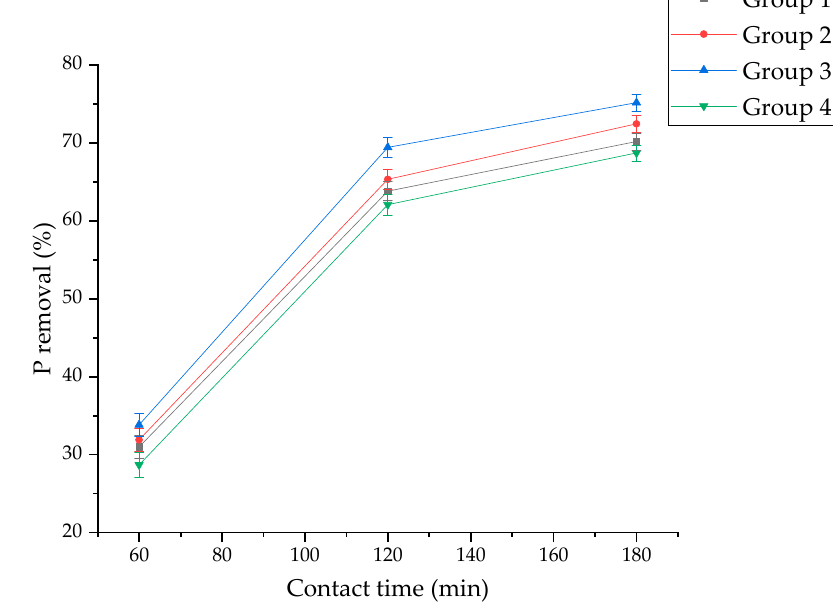
Figure 4. E ff ect of proportion of activated clay on Phosphorus removal e ffi ciency. Figure 4. Effect of proportion of activated clay on Phosphorus removal efficiency.